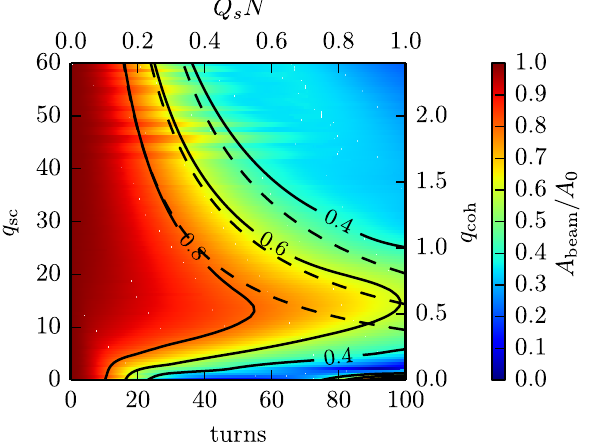
FIG. 14. Decoherence in bunches with space charge and image charges. Colors and solid lines are from simulations. Dashed lines are given by Eq. (21). Simulation parameters: a=b ¼ 1 = 5 , 1 , A σ 0 . 01 . q 0 ¼ 0 , Q s ¼ eff ¼